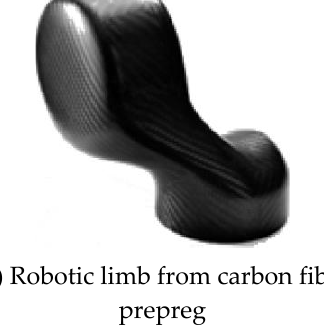
Figure 4. Robotic limb joint.